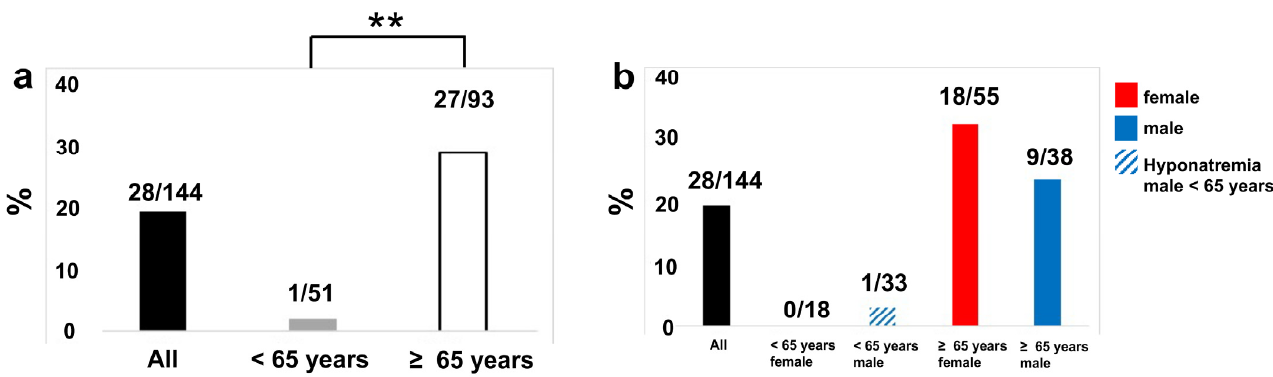
Figure 1. Distribution of hyponatremia. ( a ) Hyponatremia distribution in different age groups of the patient collective (n = 144); black bars represent the number of the whole population (n = 144), gray bars indicate hyponatremia in the age cohort younger than 65 years (n = 51), and white bars show the distribution of hyponatremia in the age cohort ≥ 65 years (n = 93; p ** = 0.0016). Distribution of patients in percent shown on the y-axis. Age cohort of patients shown on the x-axis. ( b ) Gender distribution of hyponatremia among the two age groups, i.e., patients who are younger than 65 years and 65 years or older, respectively. The percentage of patients with hyponatremia is indicated on the y-axis, and the age groups on the x-axis.